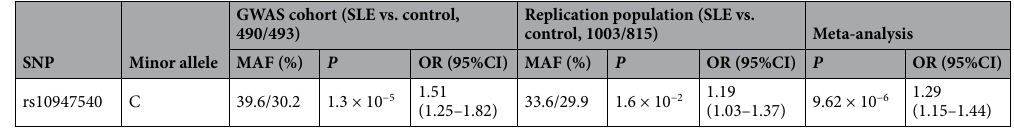
Table 1. Association of ZNF76 polymorphisms with systemic lupus erythematosus susceptibility. SNP Single nucleotide polymorphism, MAF minor allele frequency, OR odds ratio, CI confidence interval.